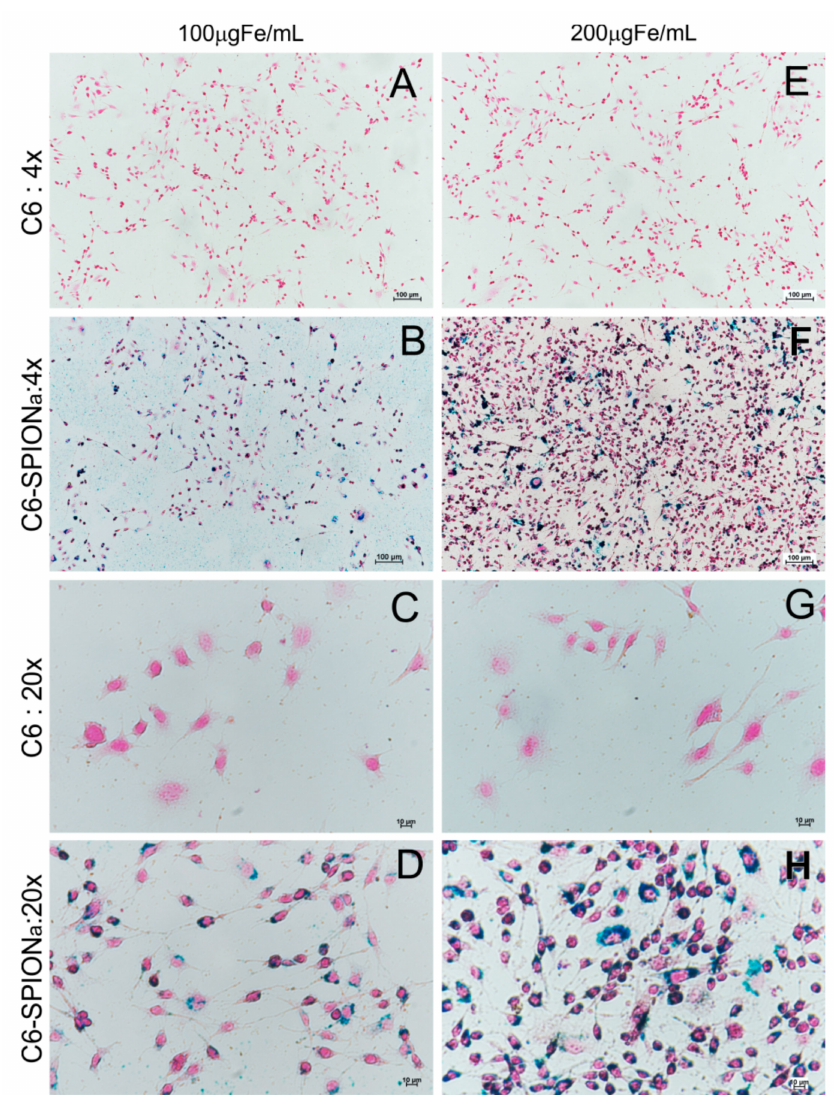
Figure 3. C6 cells labeled with SPIONa and stained with prussian blue and nuclear fast red. ( A – D ) Images of optical microscopy of the C6 cells labeled with 100 µ gFe / mL of SPIONa concentration and respective controls and ( E – H ) 200 µ gFe / mL of SPIONa and respective controls (4 × and 20 ×